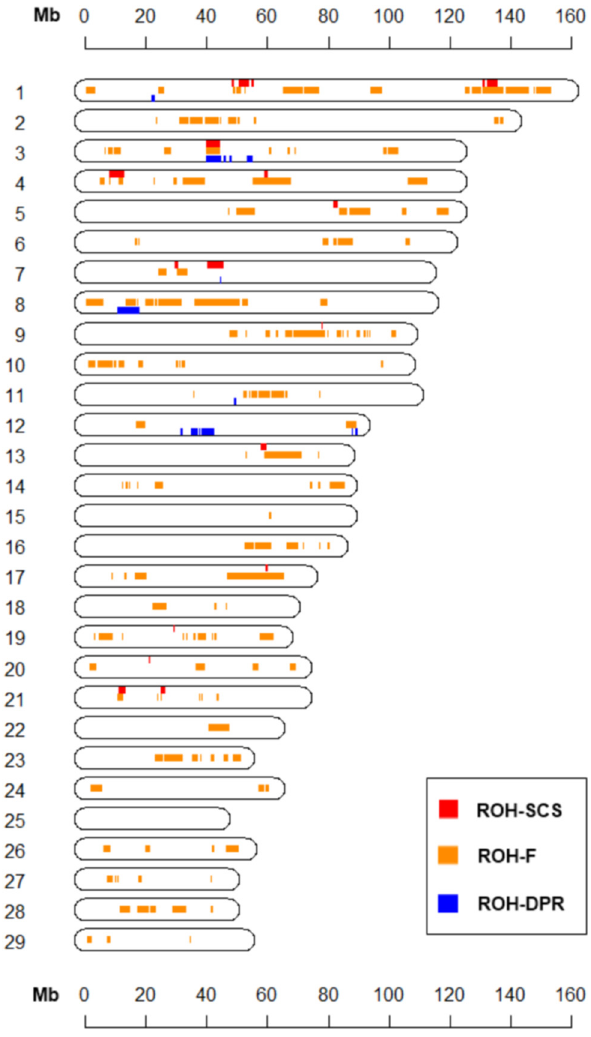
Fig 4. Comparisons of ROH-DPR, ROH-SCS and ROH-FPED. On each chromosome, red (upper), orange (middle) and blue (lower) bar display the significant associations of ROH-SCS, ROH-FPED, and ROH-DPR, respectively. The chromosome number is shown on the left side of each chromosome. Horizontal scale on top and bottom indicates genomic position (Mb) on a